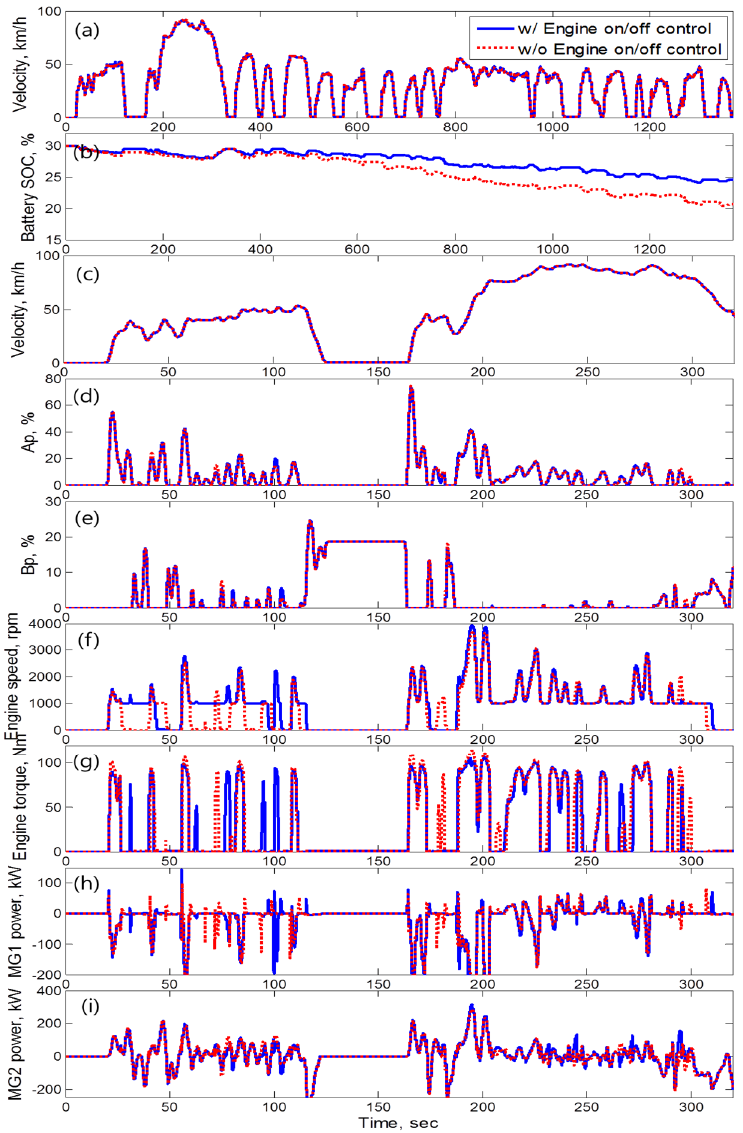
Figure 11. Simulation results of the aggressive driver (Driver 9) for engine on/off control. ( a ) velocity; ( b ) battery SOC; ( c ) velocity; ( d ) Ap; ( e ) Bp; ( f ) engine speed; ( g ) engine torque; ( h ) MG1 power; ( i ) MG2